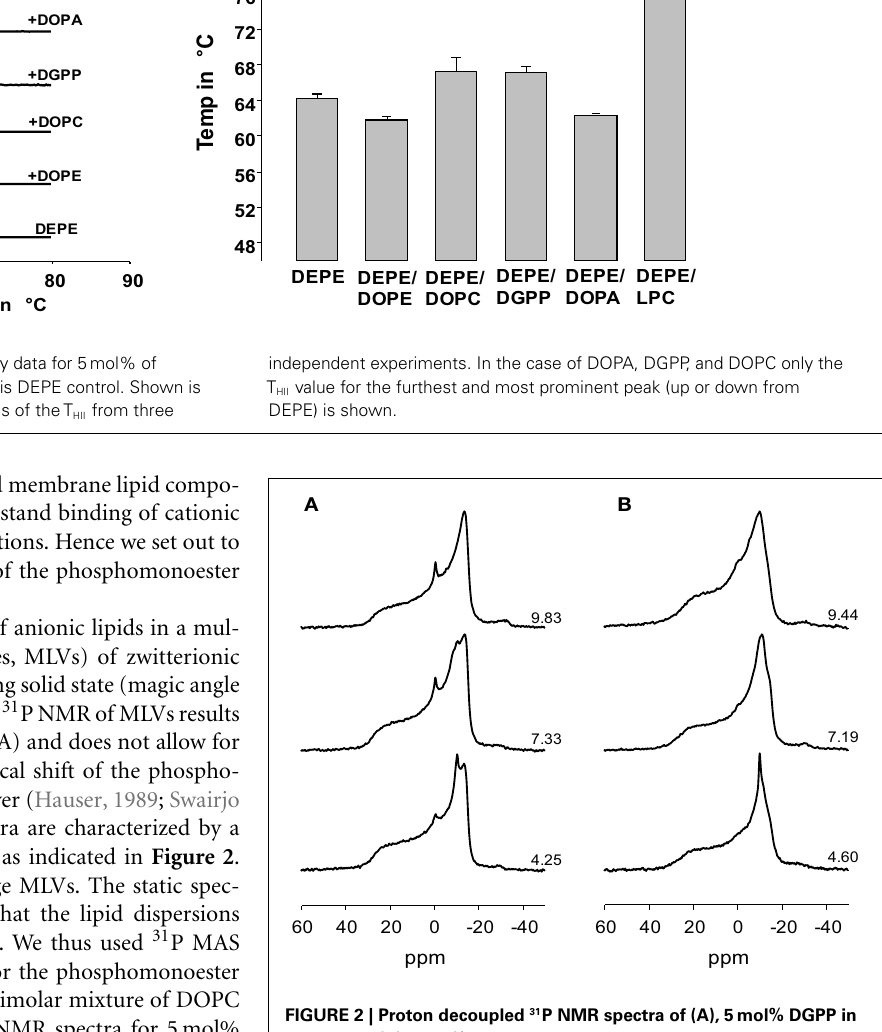
FIGURE 2 | Proton decoupled 31 P NMR spectra of (A), 5mol% DGPP in DOPC, and (B) 5mol% DGPP in an equimolar mixture of DOPC and DOPE. Spectra are plotted against an 85% H3P04 external standard, the pH of the samples is as